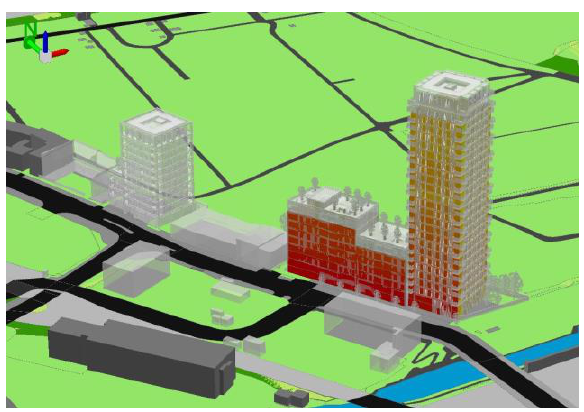
the scale of noise as it changes throughout the models. The green coloured façades are those of low dB recordings and are located mostly in the eastern and northern sides of the building, while the red indicates high noise levels. The green-red colour scale was chosen by Quod.